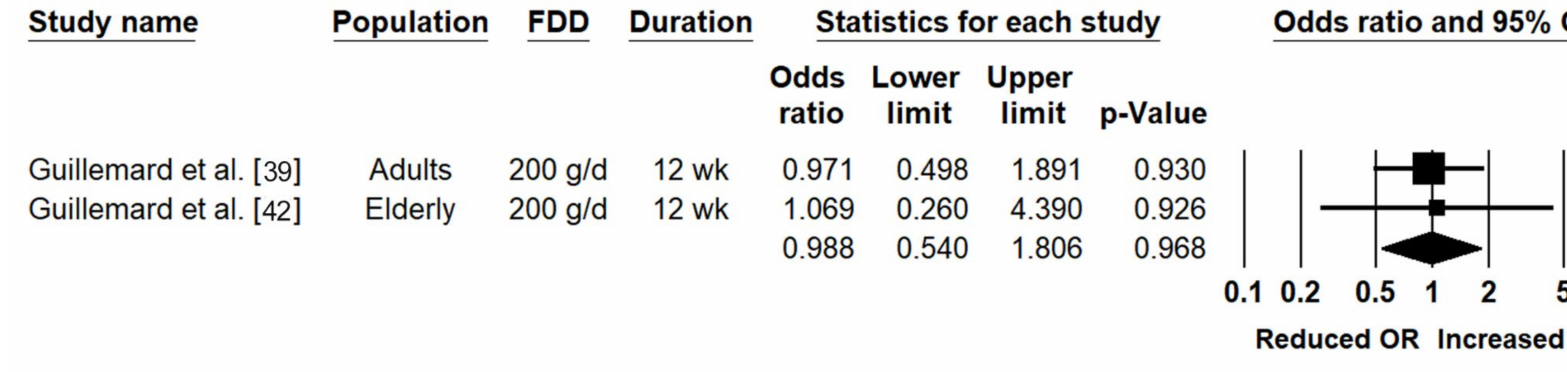
Figure 4. E ff ects of the fermented dairy drink containing Lacticaseibacillus paracasei subsp. paracasei CNCM I-1518 and the standard yogurt cultures (FDD) compared to the control on the odds of experiencing common infection diseases (CIDs) categorized as “severe” amongst subjects with CIDs. CI: confidence interval; g / d: g / day; OR: odds ratio; wk: